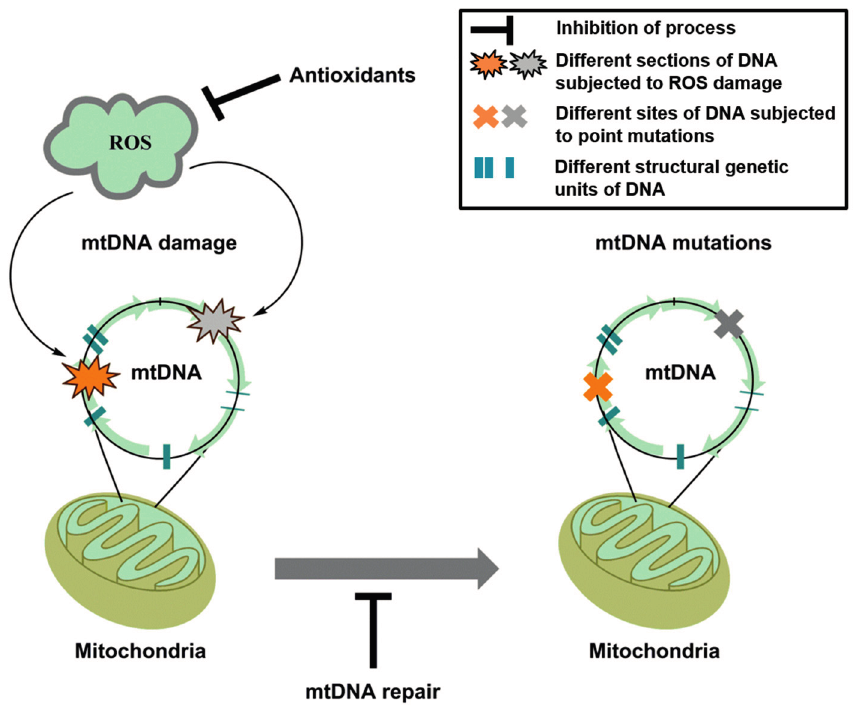
Figure 5. Schematic representation of mitochondrial DNA (mtDNA) damage by reactive oxygen species (ROS) leading to mtDNA mutations. Deleterious activity of ROS can be prevented by the administration of antioxidants. Damaged mtDNA can be repaired by the appropriate mtDNA repair pathway.